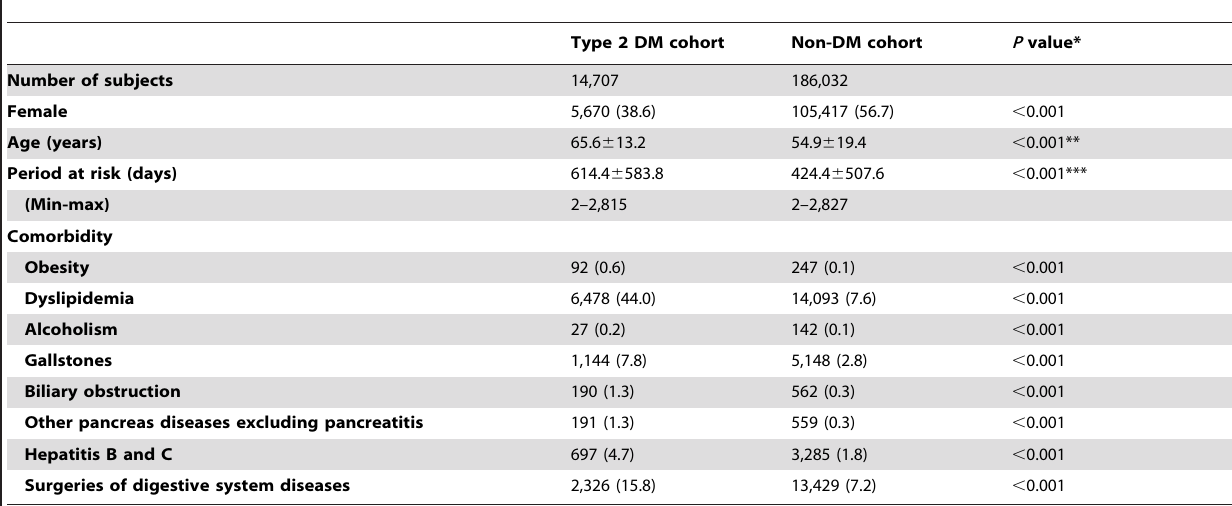
Table 1. Baseline characteristics of the type 2 DM and non-DM cohorts in the cohort